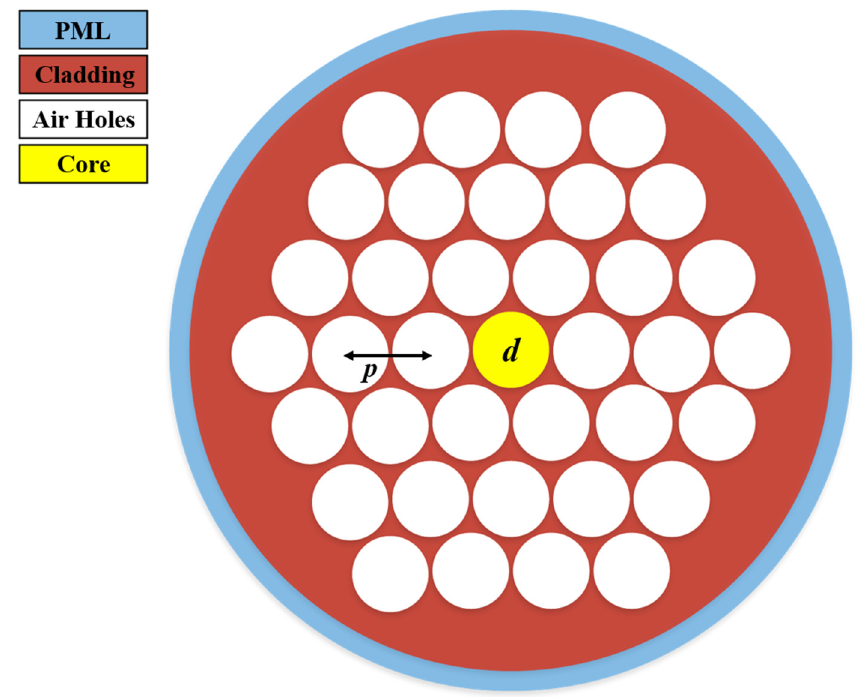
Figure 1. Design of the PCF-based sensor for liquid sensing.